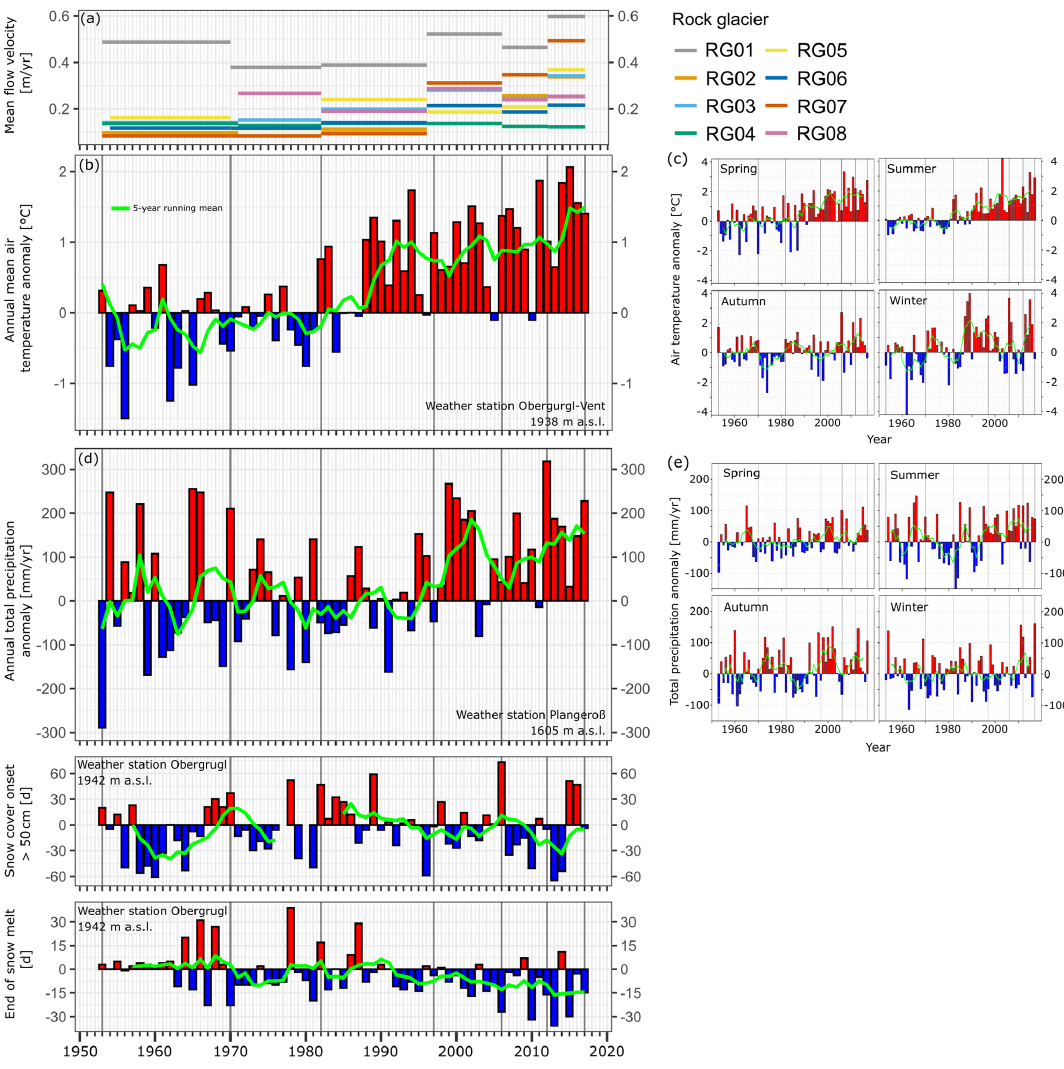
Figure 12. Flow velocity variation in the context of climatic forcing. (a) Mean flow velocities of individual rock glaciers for six epochs between 1953 and 2017. (b) Annual mean air temperature anomalies and (c) seasonal mean air temperature anomalies at the weather station Obergurgl-Vent (1938ma.s.l.). (d) Annual total precipitation anomalies and (e) seasonal total precipitation anomalies at the weather station Plangeroß (1605ma.s.l.). (f) Onset of a significant snow cover ( > 50cm), (g) end of snowmelt at the station Obergurgl (1942ma.s.l.). For (c) and (e) spring is defined as March–May, summer as June–August, autumn as September–November and winter as December–February. The reference period for the anomaly calculations is